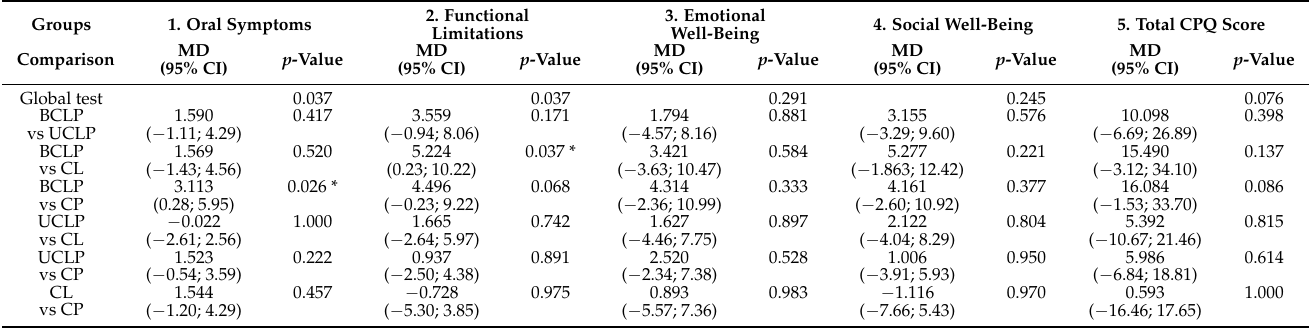
Table 4. OHRQoL within the different types of